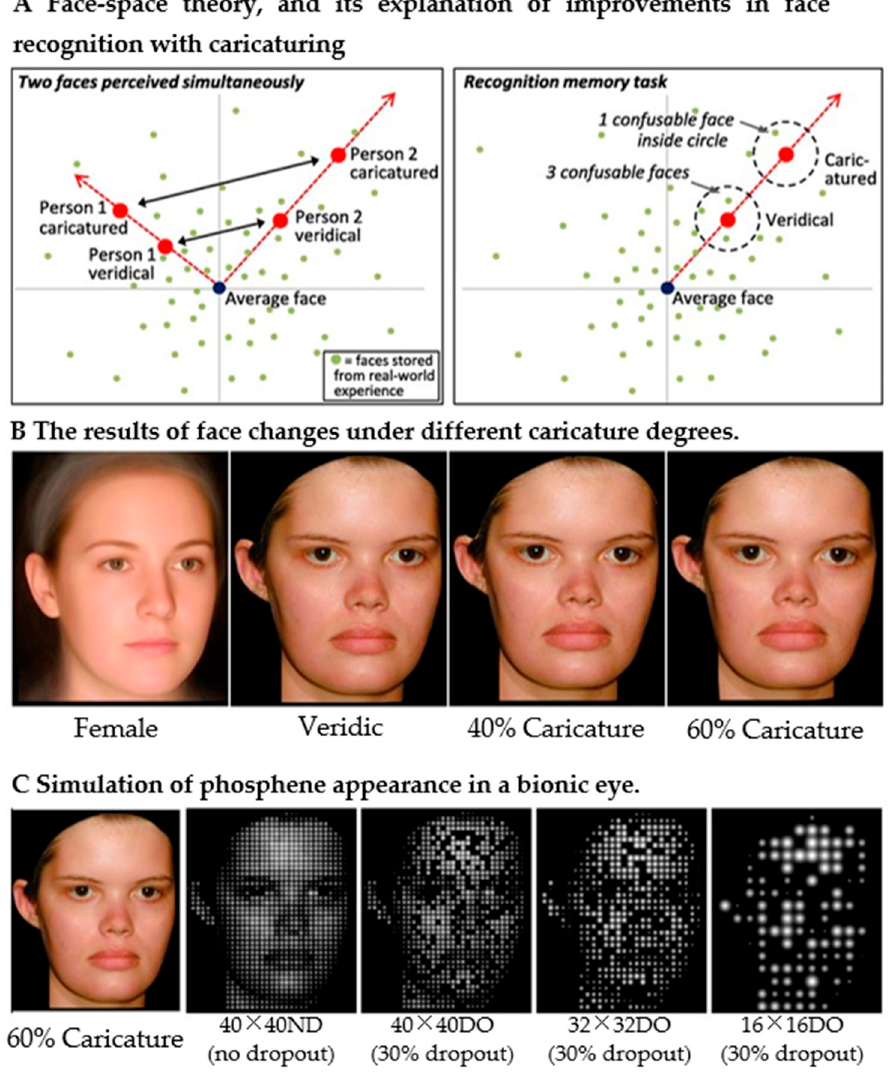
Figure 4. Schematic diagram of caricatured human face. ( A ) How faces are represented in the brain, and how this explains improved performance with caricaturing. The dimensions coded on the axes remain unknown, so they might represent the width of the face or other variables. ( B ) Examples of caricatured faces. Facial features are altered, e.g., the higher the degree of caricature, the thicker the lips become. ( C ) The leftmost is the face after 60% caricature. The three images from right to left are phosphene images with random dropout at different resolutions (adapted from